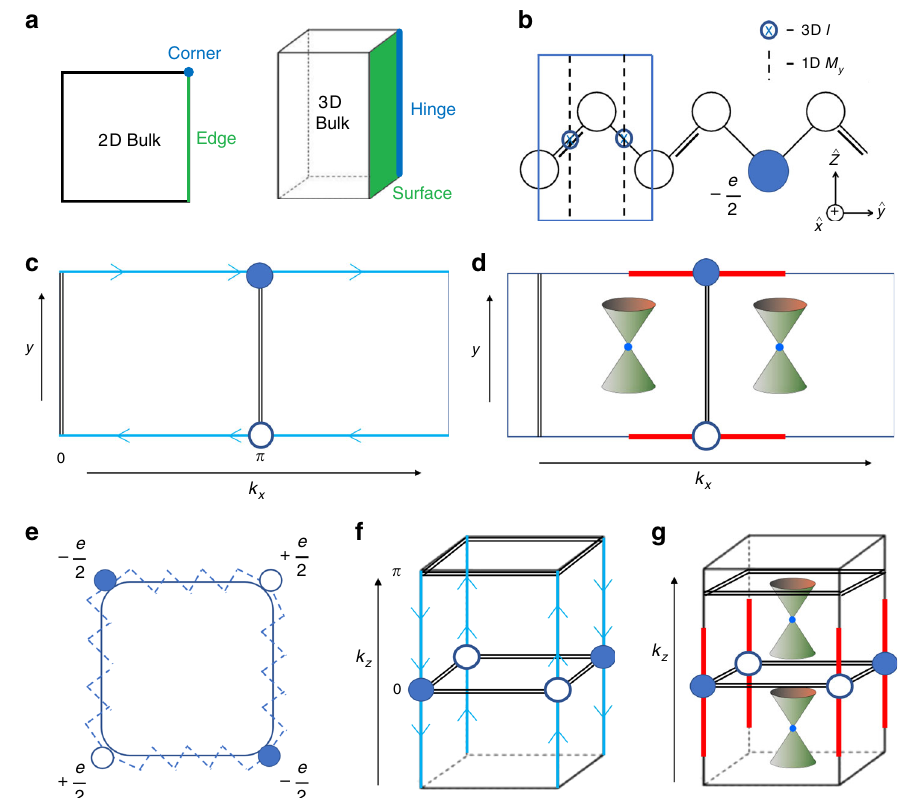
Fig. 1 Tuning cycles of 1D and 2D insulators with 0D boundary states. a Terminology for the bulk and boundary of 2D and 3D systems. b A y -directed 1D SSH chain with quantized polarization, enforced by either 3D inversion I or 1D mirror symmetry along the chain (e.g., the operation M y , which takes y → − y ) 16,17 . c In a 2D crystal with I symmetry, k x can be treated as a parameter that periodically tunes between a y -directed SSH chain (double black lines in c and d ) with zero polarization ( k x = 0) and another with e ∕ 2 polarization ( k x = π ), yielding a Chern insulator 17,40 with chiral edge modes (blue lines). d In a 2D crystal with M y symmetry instead of I , the Hamiltonian at each value of k x is equivalent to that of a y -directed SSH chain with a quantized polarization of 0 or e ∕ 2; because the polarization cannot change continuously, a periodic tuning cycle indexed by k x between SSH polarizations 0 and e ∕ 2 must pass through a pair of gapless points. This yields a 2D band-inverted semimetal with topological polarization modes (red lines) analogous to those in zigzag-terminated graphene 1,44 . e A Z 2 quantized quadrupole insulator (QI) 23 invariant under wallpaper group p 4 m . f A C 4 z -broken, mirror-preserving pumping cycle of a QI (double black lines in f and g ) is equivalent to a 3D 2nd-order Chern insulator 24 – 27 with chiral hinge modes (blue lines), whereas g a p 4 m -preserving cycle is equivalent to a 3D Dirac semimetal with higher-order Fermi arcs (HOFAs) on its 1D hinges (red